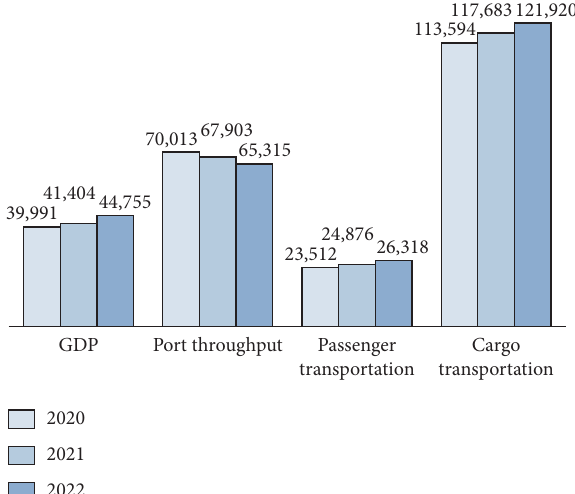
Figure 4: Simulation prediction when COVID-19 does not occur.